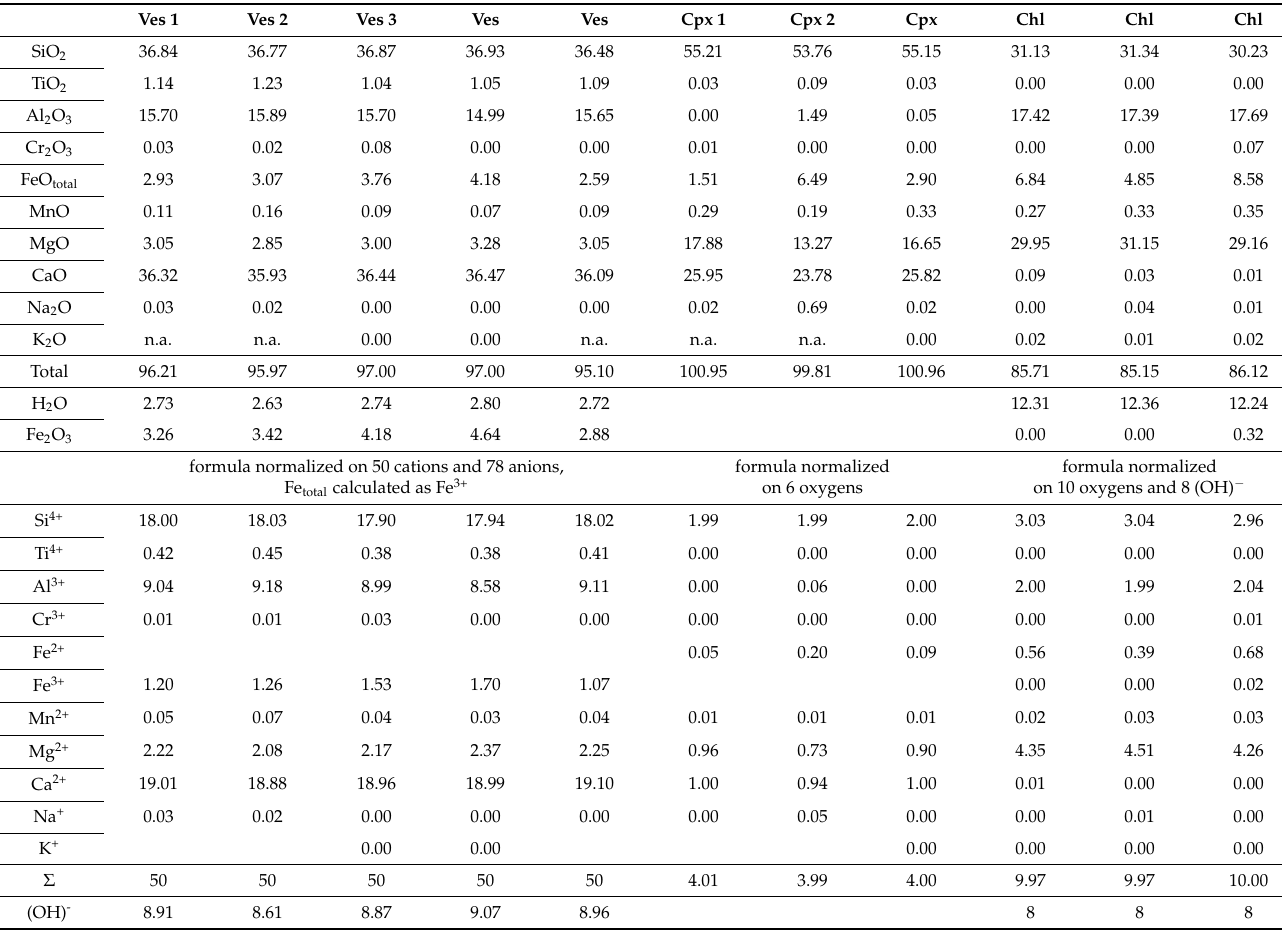
Table 2. Representative electron-microprobe compositions (wt%) of vesuvianites, clinopyroxenes and chlorites from Dobšin á